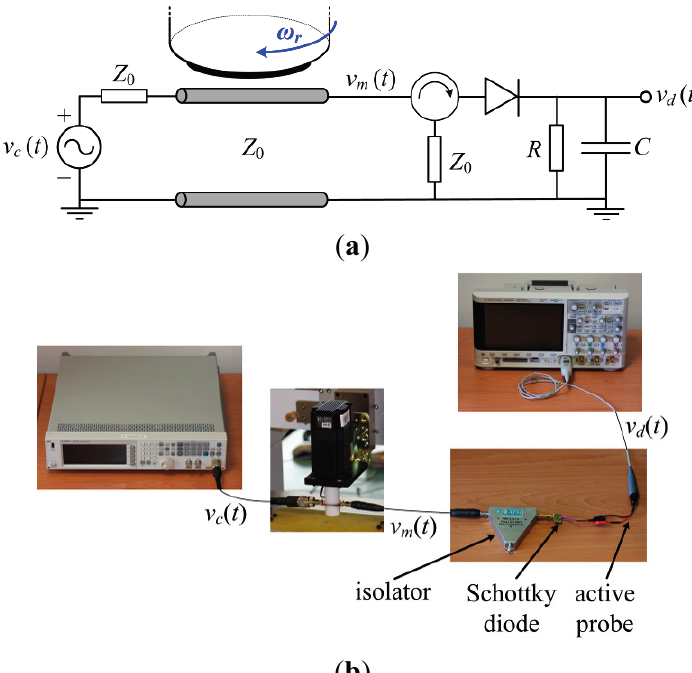
Figure 16. Scheme ( a ) and experimental set-up ( b ) for the measurement of the angular velocity. The carrier signal has been generated by means of the Agilent N5182A signal generator, whereas the output waveform has been recorded by the Agilent 3054A oscilloscope. The isolator has been implemented with the ATM ATc1-2 circulator, with one of the ports terminated with a matched 50- Ω load. The envelope detector is synthesized by the Avago Technologies HSMS-2860 Schottky diode and the single-ended